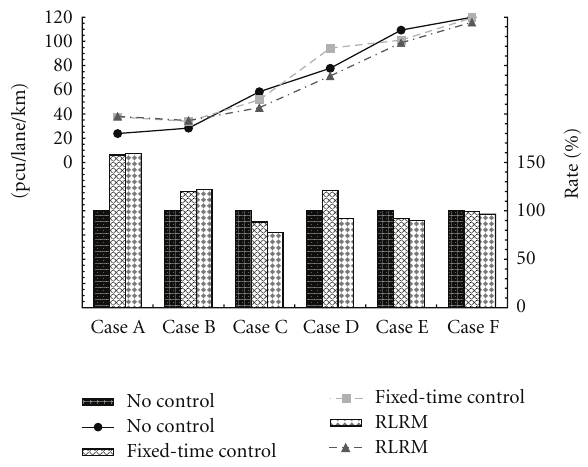
A to case F arrive at 7.06%, 0.58%, 3.85%, 10.47%, 54.63%, and 30.65%, respectively.